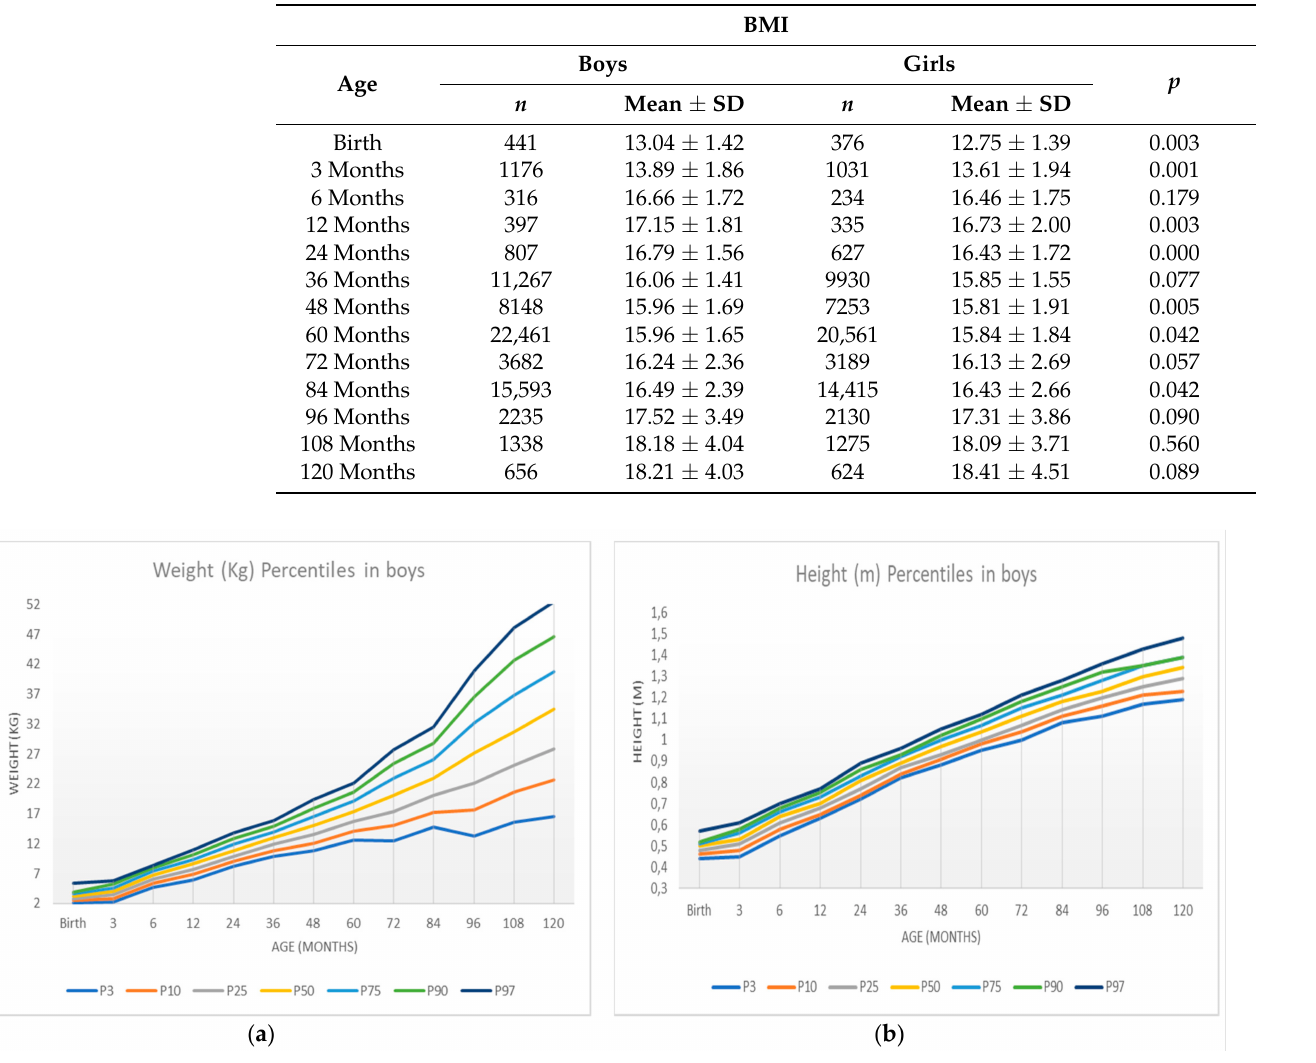
Table 5. BMI comparisons between boys and girls by age.